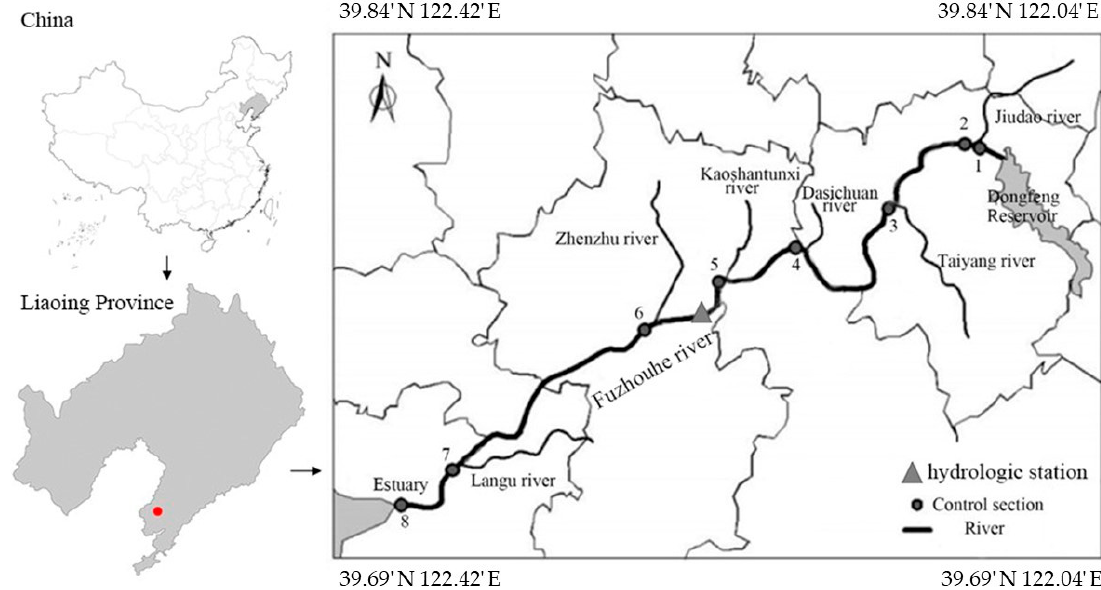
Figure 1. Schematic diagram of study area.